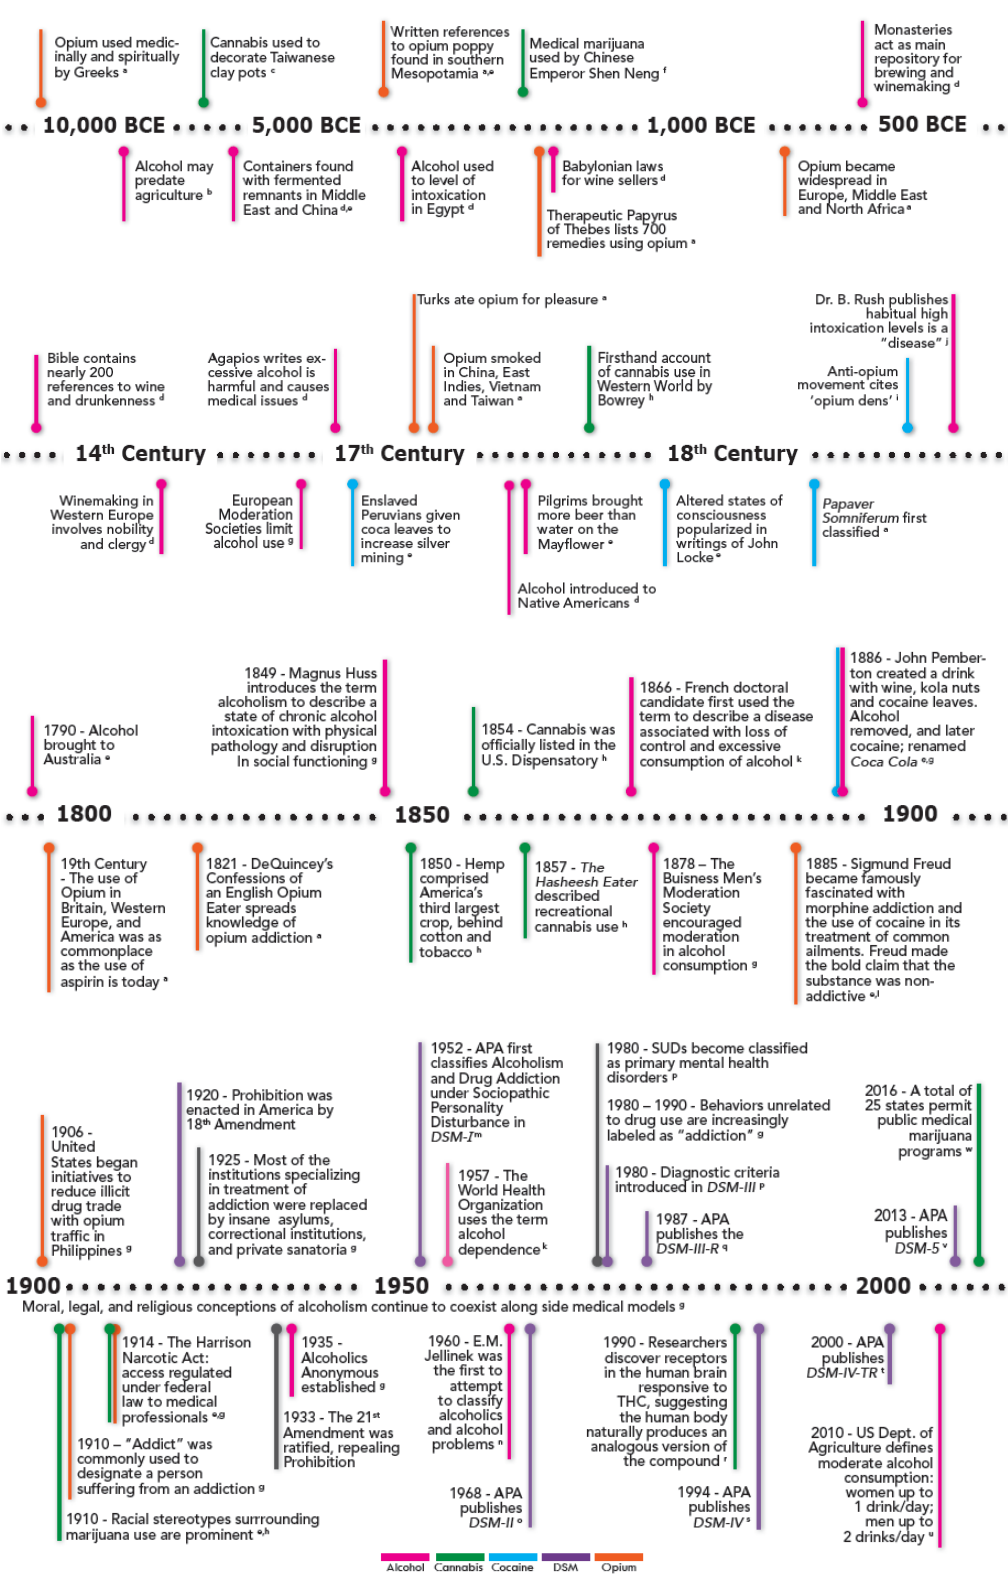
Figure 1. Selection of additional/supplementary historical events and perspectives related to the use of substances over time, nosological developments, and other domains relevant to the main text.